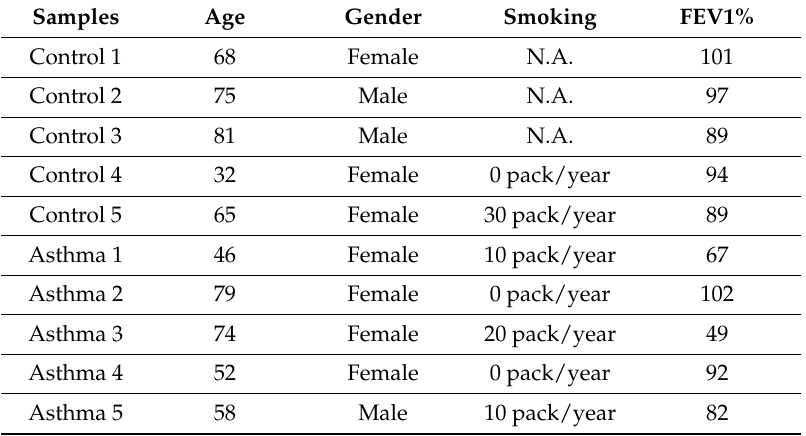
Table 1. Demographic information of tissue